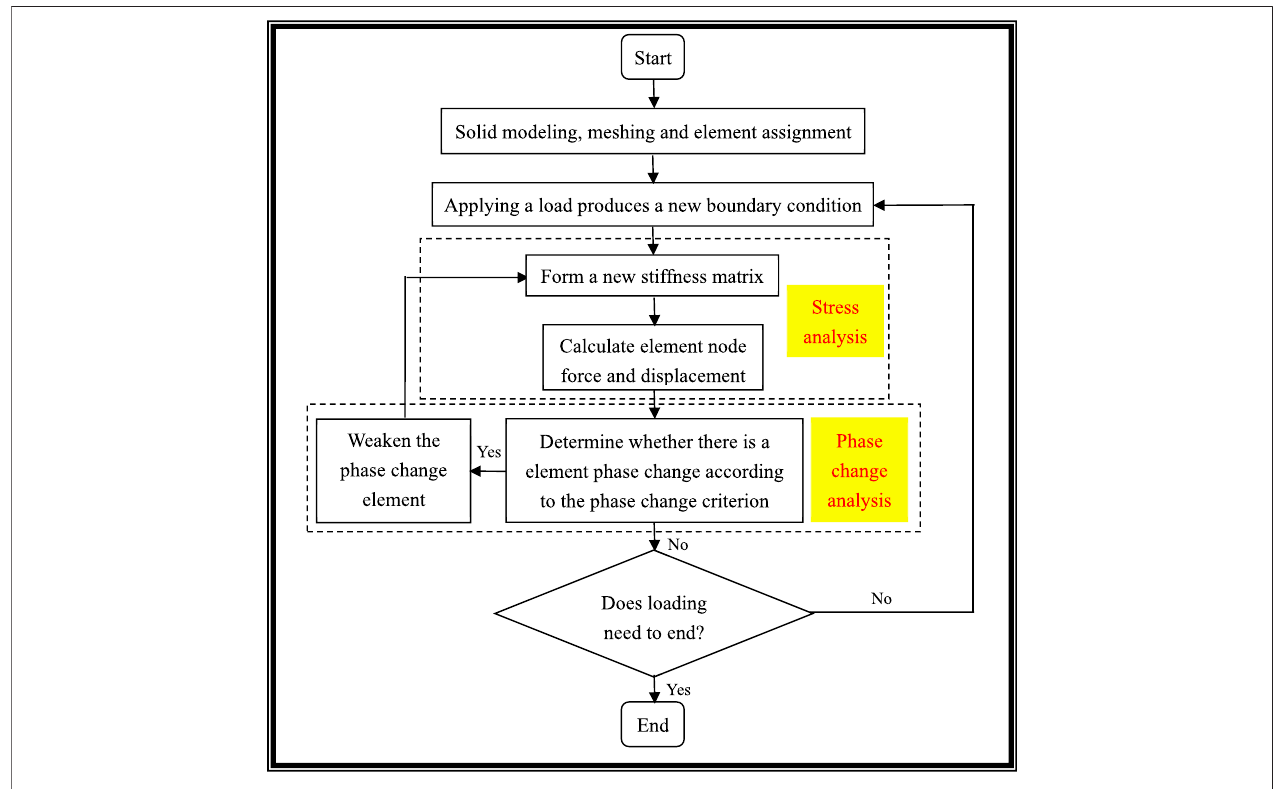
FIGURE 3 | RFPA software work fl ow picture.